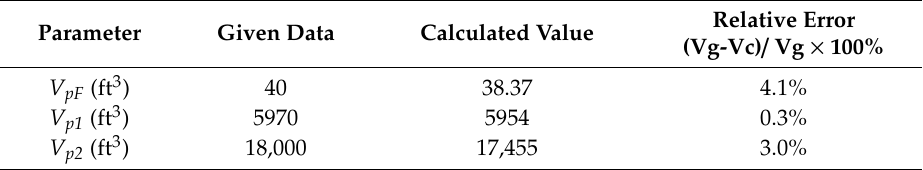
Table 3. Inferred parameter values according to the fitting